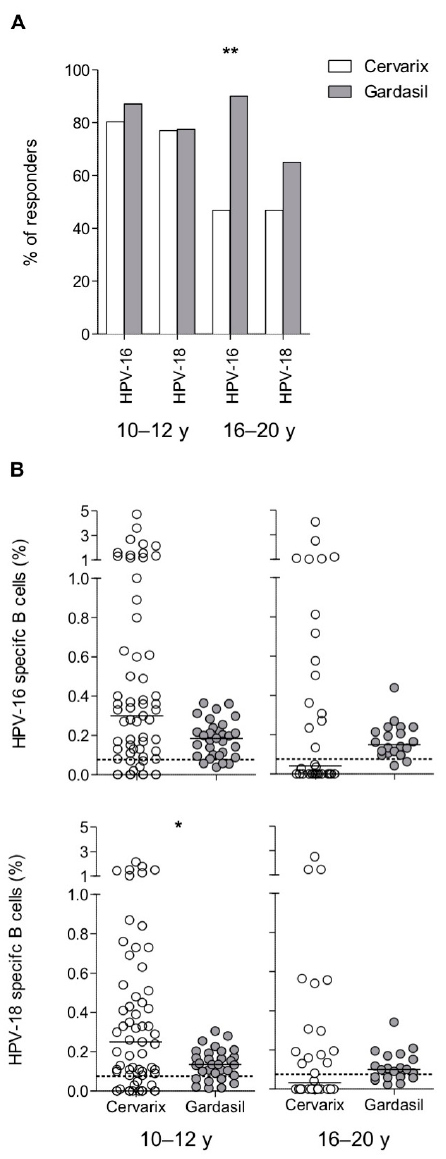
Figure 4. Maintenance of HPV-16 and HPV-18 specific memory B cells. ( A ) Frequency of study subjects with detectable HPV-16 and HPV-18 specific memory B cells. ( B ) HPV-16 and HPV-18 specific memory B cells measured by B cell Elispot assay. Each dot represents a single donor, solid lines are the medians and dashed lines are the cut-off values to determine the B cell Elispot positivity. Statistical comparisons were made using Fisher’s exact probability test ( A ) and Mann–Whitney test ( B ), * P < 0.05, ** P < 0.01; for HPV-16 10–12 y, n = 61 (Cervarix) and n = 31 (Gardasil); for HPV-16 16–20 y, n = 32 (Cervarix) and n = 20 (Gardasil); for HPV-18 10–12 y, n = 61 (Cervarix) and n = 31 (Gardasil); for HPV-18 16–20 y, n = 32 (Cervarix) and n = 20 (Gardasil). 3.4. Maintenance of HPV-6 and HPV-11-Specific Responses After Vaccination with Gardasil While Cervarix only contains antigens from two HPV strains (HPV-16 and HPV-18), Gardasil also immunizes against HPV-6 and HPV-11 subtypes. HPV-6 specific IgG were maintained in 74% of 10–12 y and in 55% of 16–20 y vaccinated individuals, while the proportion for HPV-11 responders were higher (94% and 70%, respectively, Supplementary Material Figure S3A). Notably, IgG titers